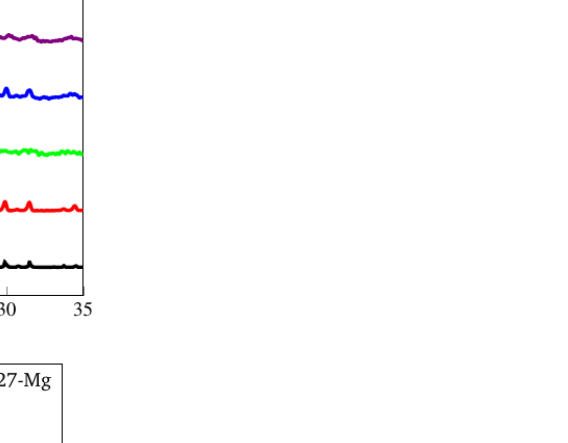
Figure 4. EDX spectrum of crystallized CPO-27-Mg.